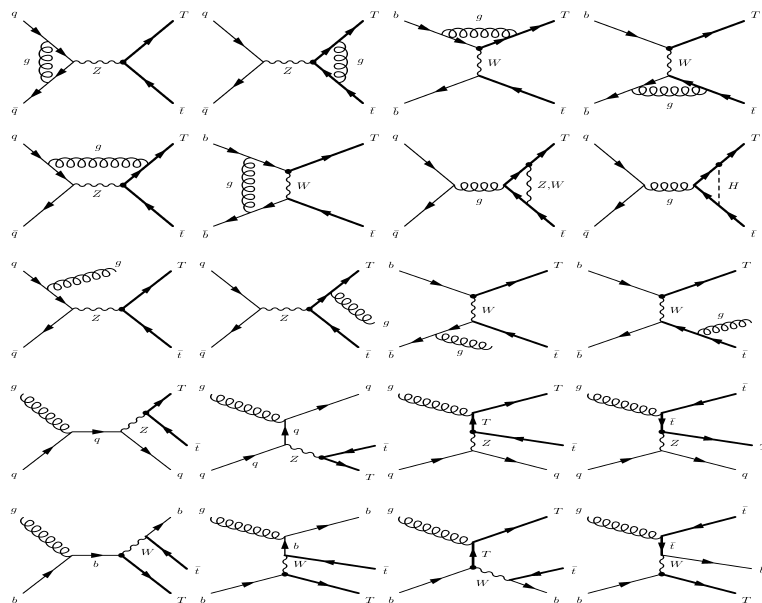
Figure 2 . Some of one-loop and real emission Feynman diagrams associated to both Born diagrams. those processes are shown in (cid:12)gure 1. The one-loop virtual amplitude, of order O ( (cid:11) 2 (cid:11) obtained by interfacing the weak Born Feynman diagrams, shown in (cid:12)gure 1, with all their one-loop QCD virtual correction diagrams with at least one virtual gluon running on the loop, i.e. we keep all the triangles and the boxes with at least two strong vertices. In the (cid:12)rst and the second lines of (cid:12)gure 2, we depict some of the one-loop Feynman diagrams.